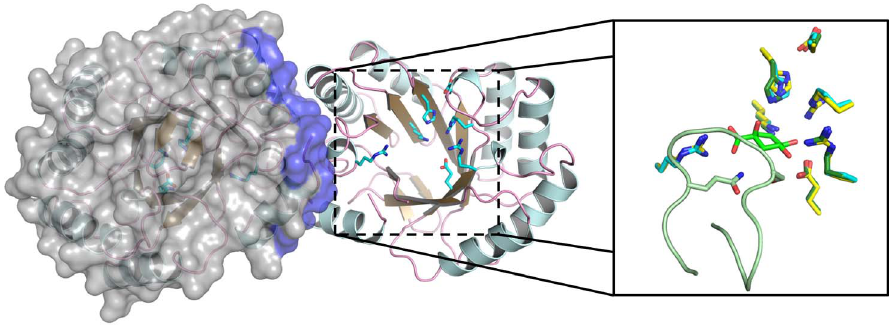
Figure 5. Crystal structure of efDHQase. The biological assembly of efDHQase is a homodimer. Alpha-helices, b -strands, and loops are shown as cartoon representations and colored light blue, golden, and pink, respectively, to visualize the ( b / a ) 8 -barrel scaffold on each monomer. Residues at the dimer interface are highlighted purple on the surface (grey) of one monomer. Residues involved in ligand binding are shown as sticks and colored cyan. Comparison of efDHQase’s active center with homologous 3-dehydroquinate dehydratases from Salmonella enterica (seDHQase) and Clostridium difficile (cdDHQase) is shown in the magnified view on the right. The structures were superimposed onto each other using the C a atoms of the ligand-binding residues, with the residues from seDHQase and cdDHQase colored dark green and yellow, respectively. The pre-dehydration intermediate covalently-attached to seDHQase is drawn as green sticks. Part of the b 8- a 8 loop from seDHQase is shown as light green cartoon representations.